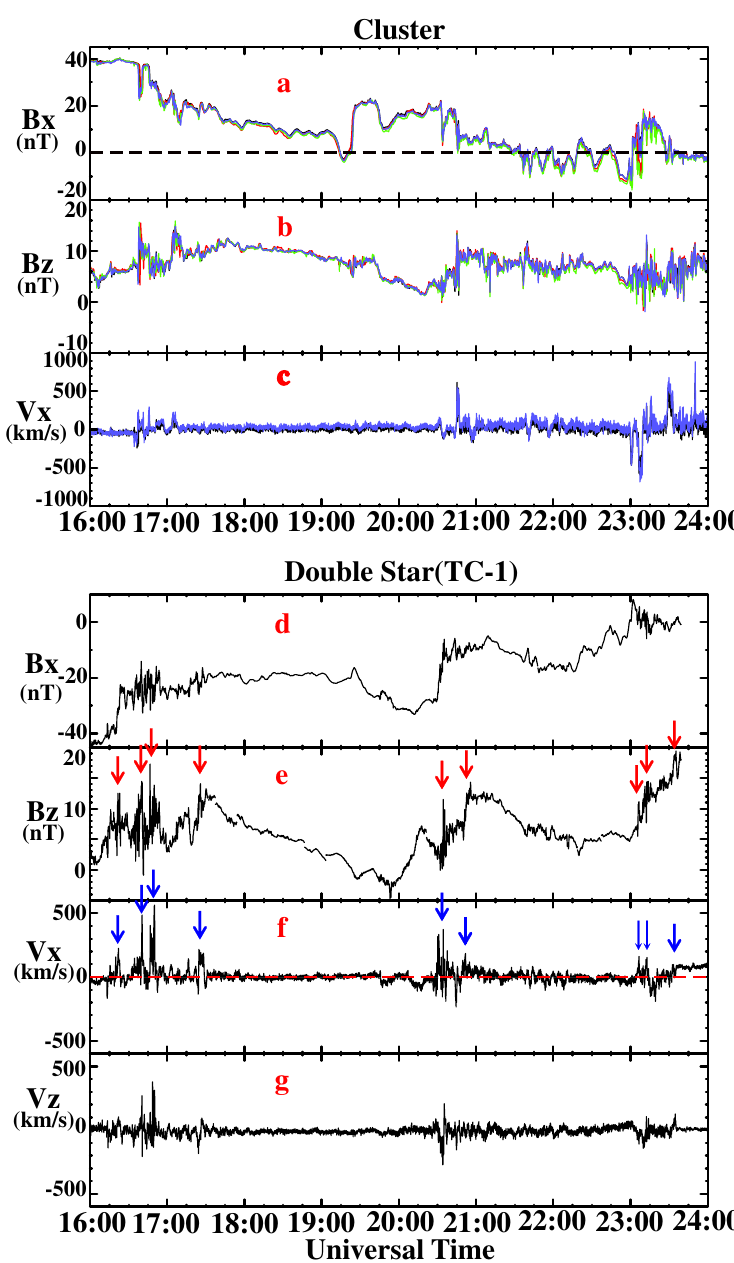
Fig.2 Deng et al. Fig. 2. Overview of the Cluster and Double Star (TC-1) data. In the upper part, from top to bottom, are the magnetic field components of B x and B z , and ion flow velocity of V x of Cluster, respectively. At the bottom, from top to bottom, are the magnetic field components of B x and B z , and ion flow velocity of V x and V y of TC-1. Vectors are on the GSM frame of reference. SC1, SC2, SC3 and SC4 are represented by black, red, green and blue lines,